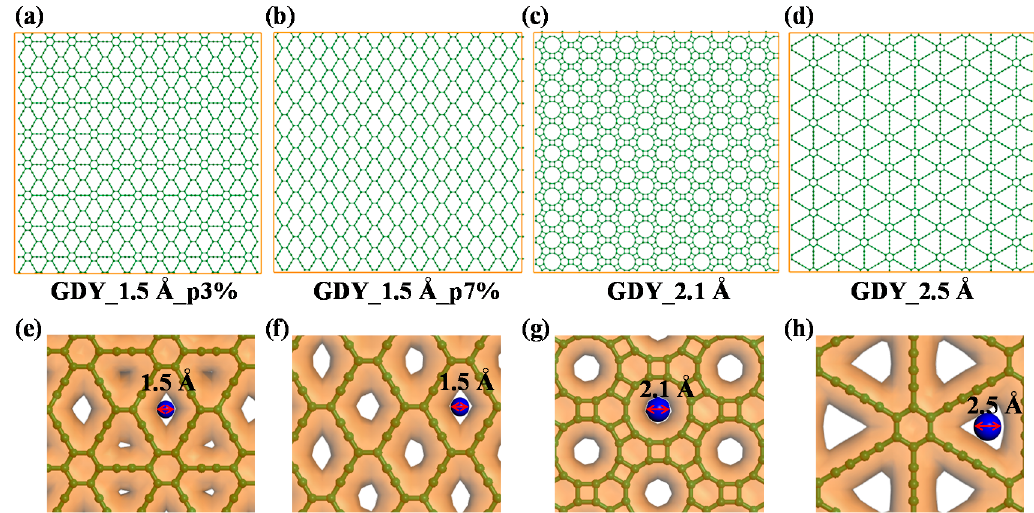
Figure 1. Membrane models. Atomic structures of graphdiyne (GDY) membranes with different pore structures: ( a ) GDY_1.5Å_p3%; ( b ) GDY_1.5Å_p7%; ( c ) GDY_2.1Å; and ( d ) GDY_2.5Å. The first two